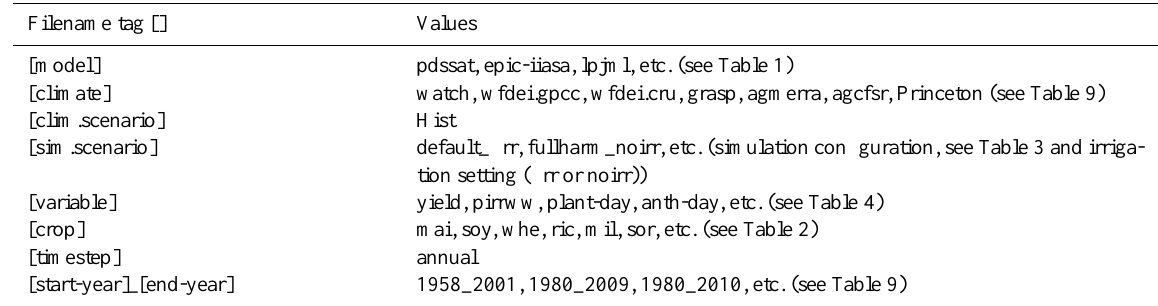
Table 6. Filename conventions for standardized model outputs.